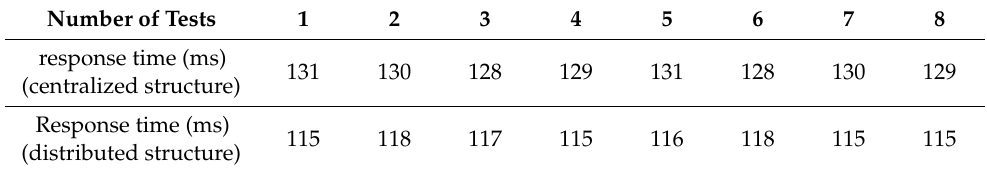
Table 2. Results of the test (time